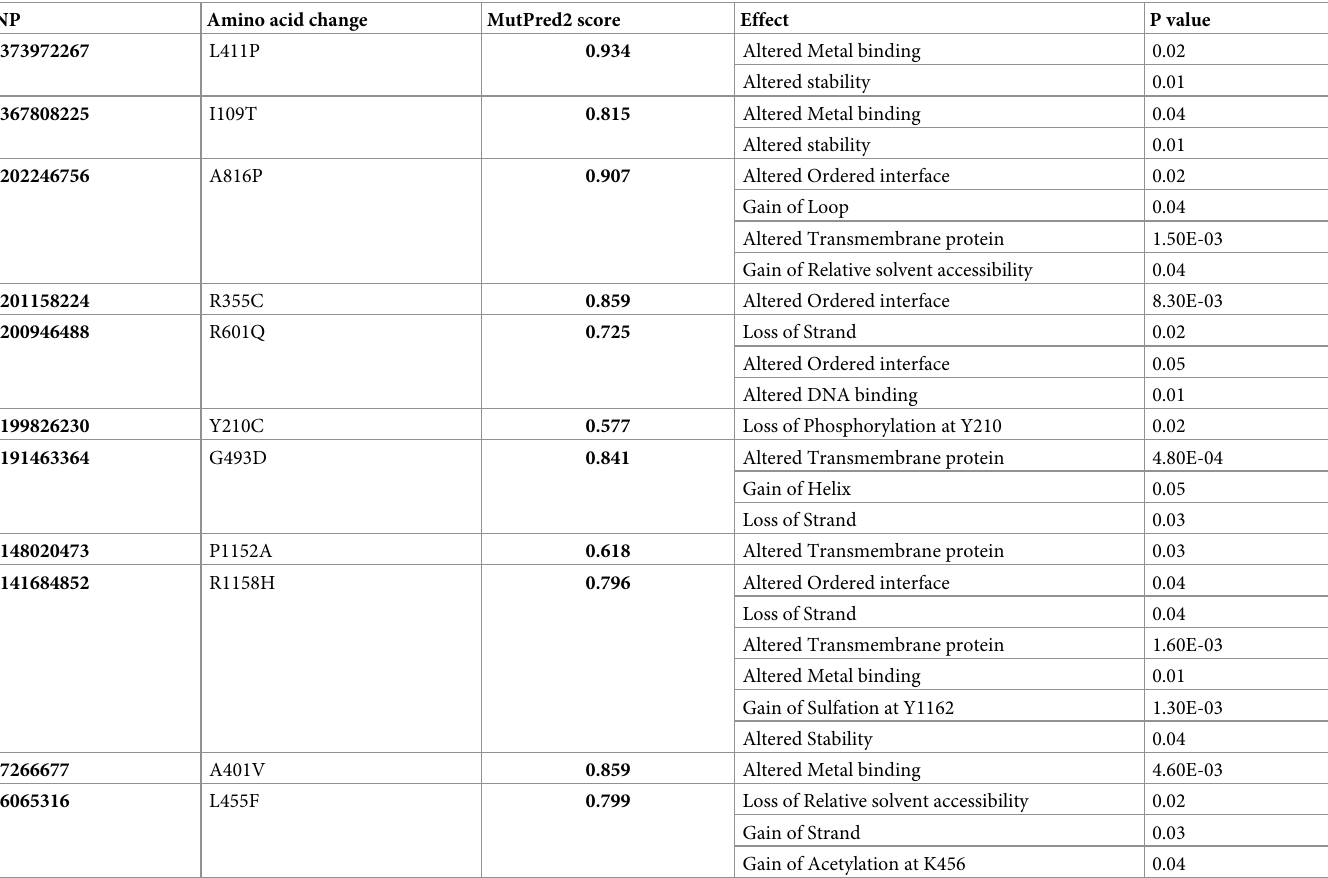
Table 4. Effect of nsSNPs on the structure and function of protein predicted by Mutpred2.